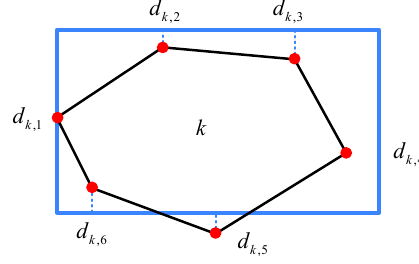
Figure 5. Location Registration.